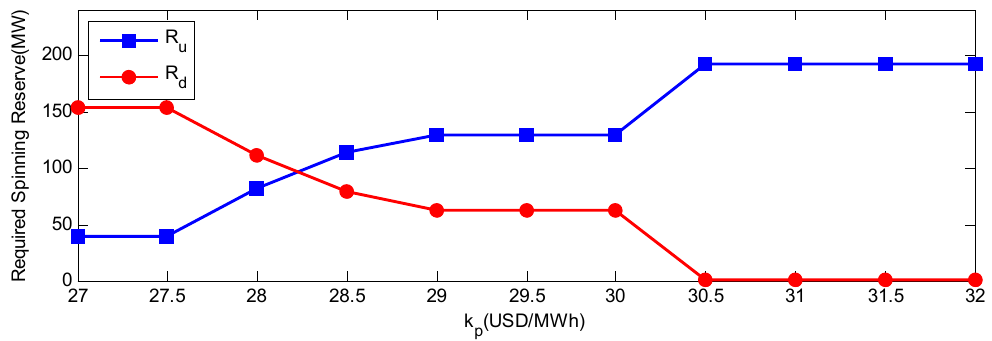
Figure 10. The required up/down spinning reserve as a function of down reserve cost